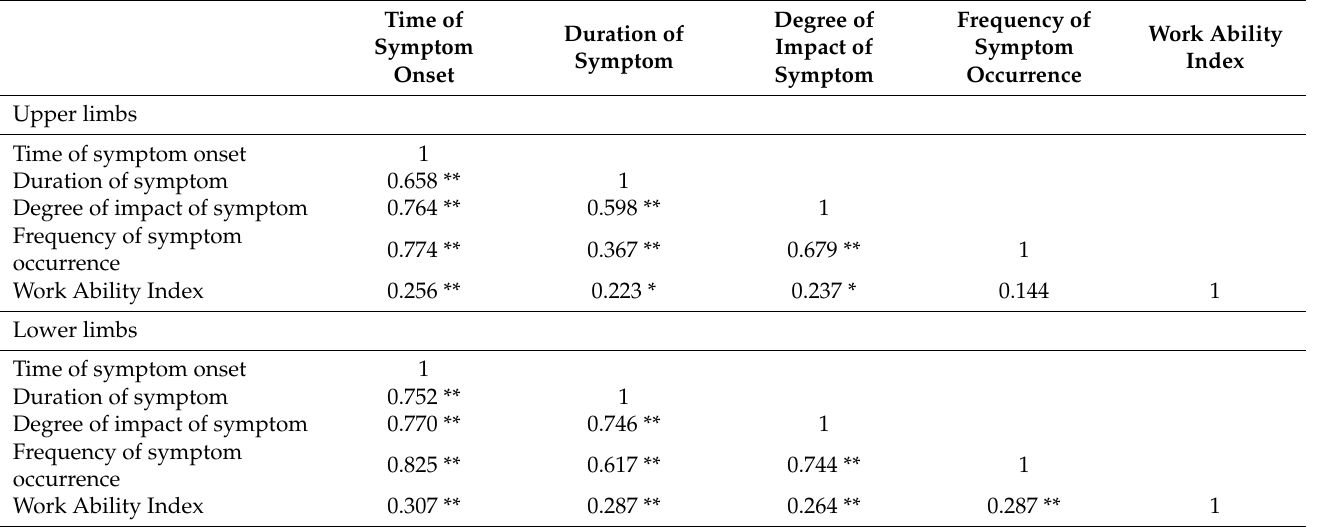
Table 6. Correlation between the subjective NMQ and the work ability